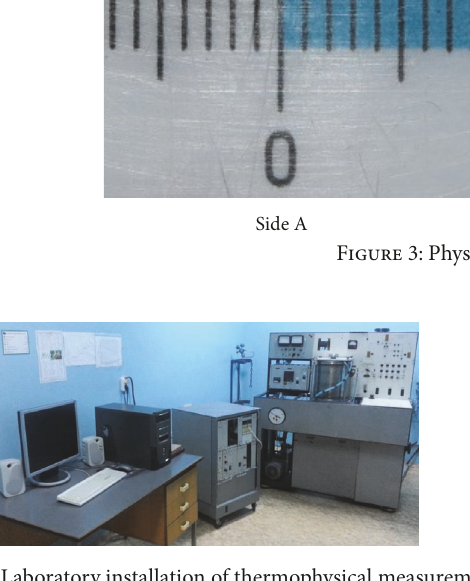
Figure 4: Laboratory installation of thermophysical measurements of